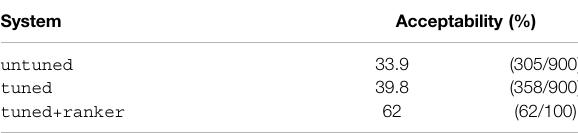
Toevaluate untuned and tuned ,acceptabilityiscalculatedoverall9continuations from each system, while t uned+ranked uses the Ranker to consider only the best one. Reproduced with permission from (Nichols et al.,